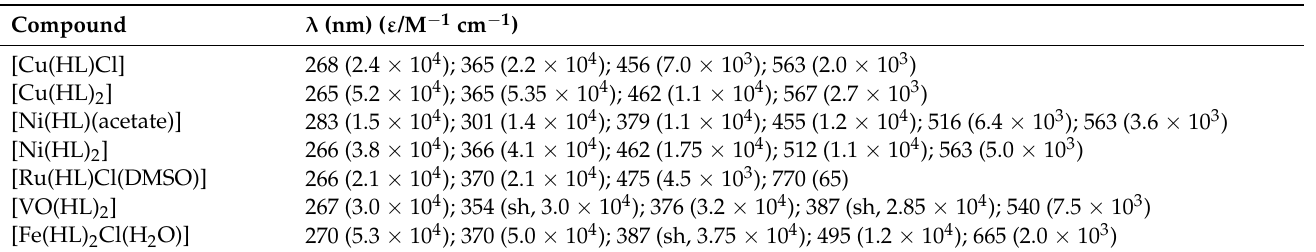
Table 2. UV-vis absorption bands of the complexes in DMSO solutions—indication of the maxima λ in nm and the extinction coefficients ( ε /M − 1 cm − 1 ). Shoulder (sh).